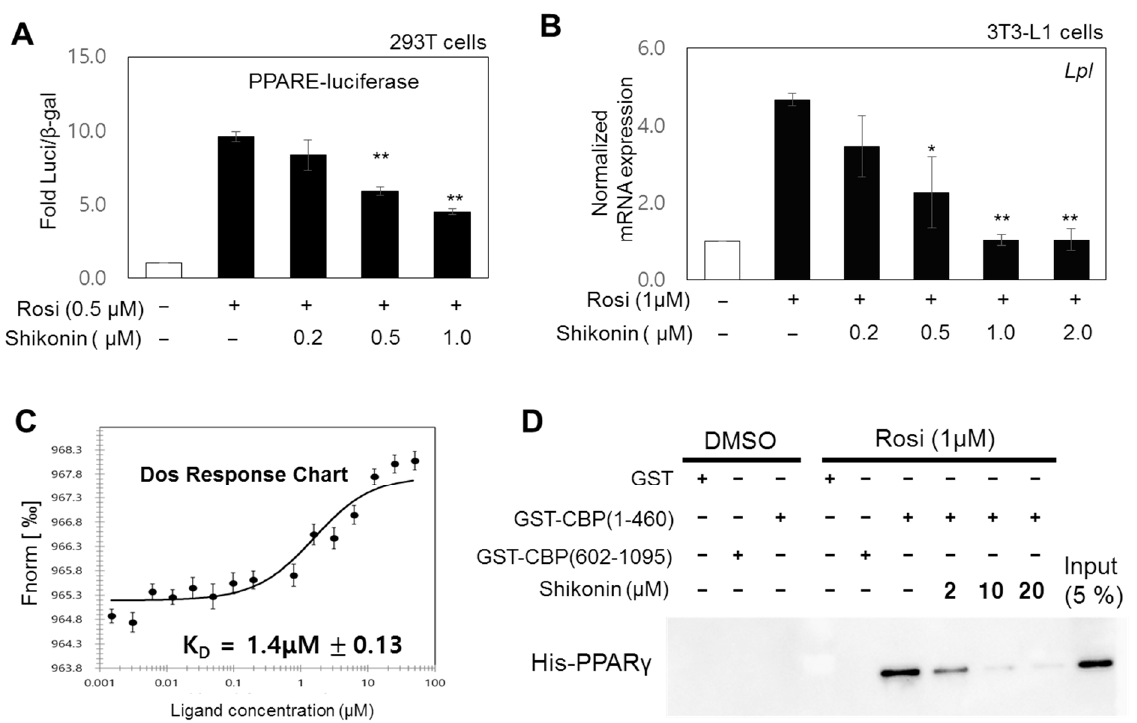
Figure 3. Antagonistic effects of shikonin on PPAR γ regulation. ( A ) Results of the luciferase reporter gene assay. HEK293 cells were cotransfected as described in the Materials and Method section and treated with rosiglitazone (Rosi, 0.5 µM) and the indicated concentrations of shikonin. Luciferase values were normalized to the β -galactosidase activity. The error bars represent means ± SDs of three independent experiments (** p < 0.01). ( B ) Effects of shikonin on Rosi-induced expression of the Lpl gene. 3T3-L1 cells were differentiated and treated with 1 µ M of Rosi and the indicated concentrations of shikonin for 6 days. Expression of mRNA, measured by RT-qPCR, was normalized to the GAPDH expression level and indicated as fold change relative to that of the DMSO control. Bars represent means ± SDs of three independent experiments (* p < 0.05 and ** p < 0.01). ( C ) Microscale thermophoresis (MST) assays were performed as described in the Materials and Methods section. ( D ) Effects of shikonin on the rosiglitazone-induced interaction of PPAR γ with the coactivator CBP. GST pull-down assays were performed as described in the Materials and Methods section. The immobilized GST-CBP (amino acids 1–460 or 602–1095) fusion protein was incubated with the indicated concentration of shikonin in the presence of 1 µ M of Rosi and a His-PPAR γ ligand-binding domain (LBD). Bound proteins were visualized by western blotting using an anti-His antibody. The input represents 5% of His-PPAR γ used for the binding